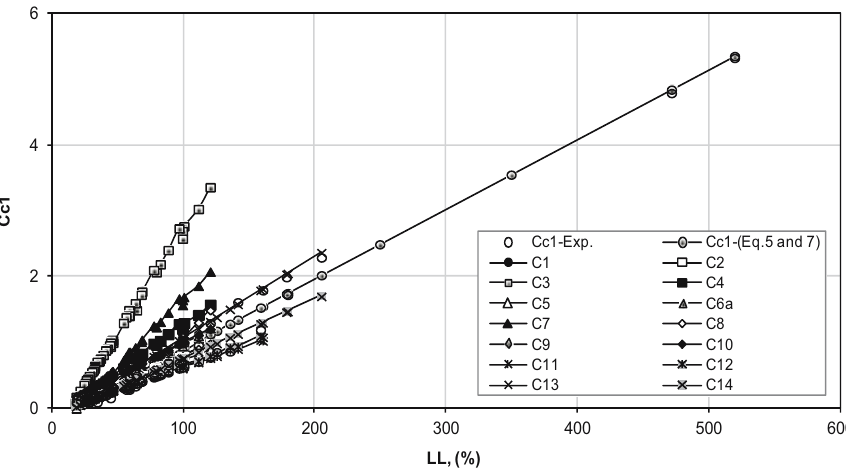
Figure 10: The comparison between the new Eqs. ( 5 ) – ( 7 ) of C c1 vs complete range of LL and the other previous empirical equations in Table 1 for the given 59 di ff erent soils used in this study.